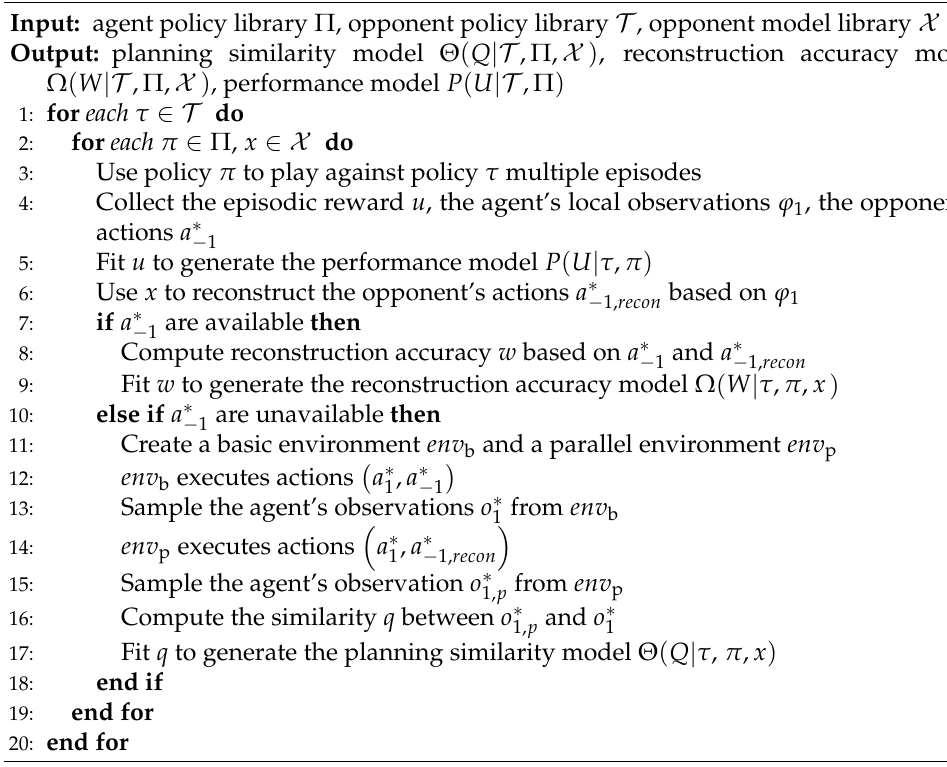
Algorithm 1 Offline models’